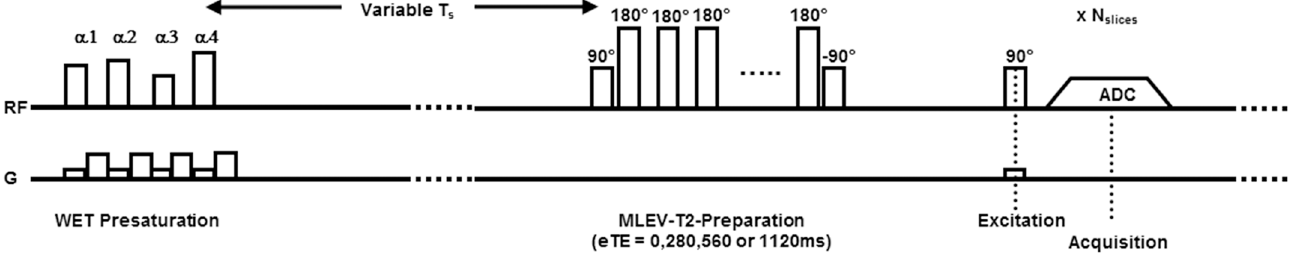
Fig 2. The ICV derived from the CSF MRI sequence. Example of the ICV in an axial (A), saggital (B) and coronal (C) slice. The mask resulting from the BET application to the CSF data is shown in red. The raw CSF data is shown in gray-scale in the